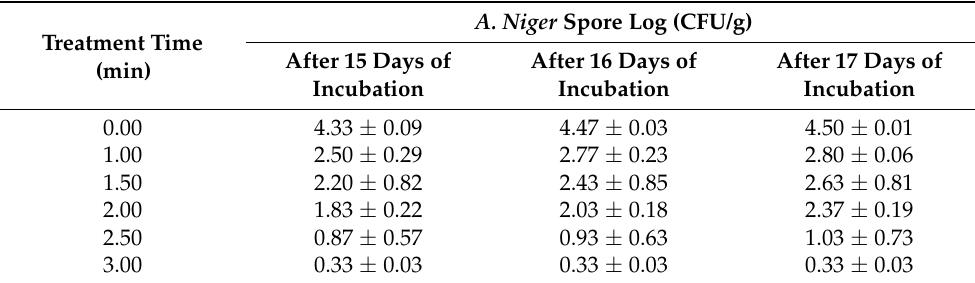
Table 1. The effect of SDBD plasma on A. niger spore log (CFU/g) at different treatment time; p value =